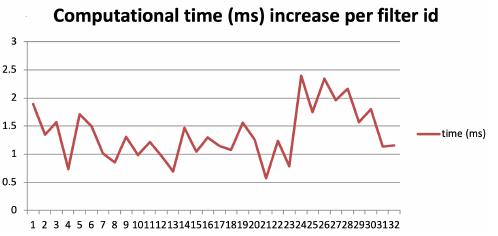
Figure 22. Computational time (ms) increase per filter due to the proposed algorithm. The testbed is the MNIST dataset and the comparison entails the first layer of the vanilla and proposed architecture, as described earlier in the